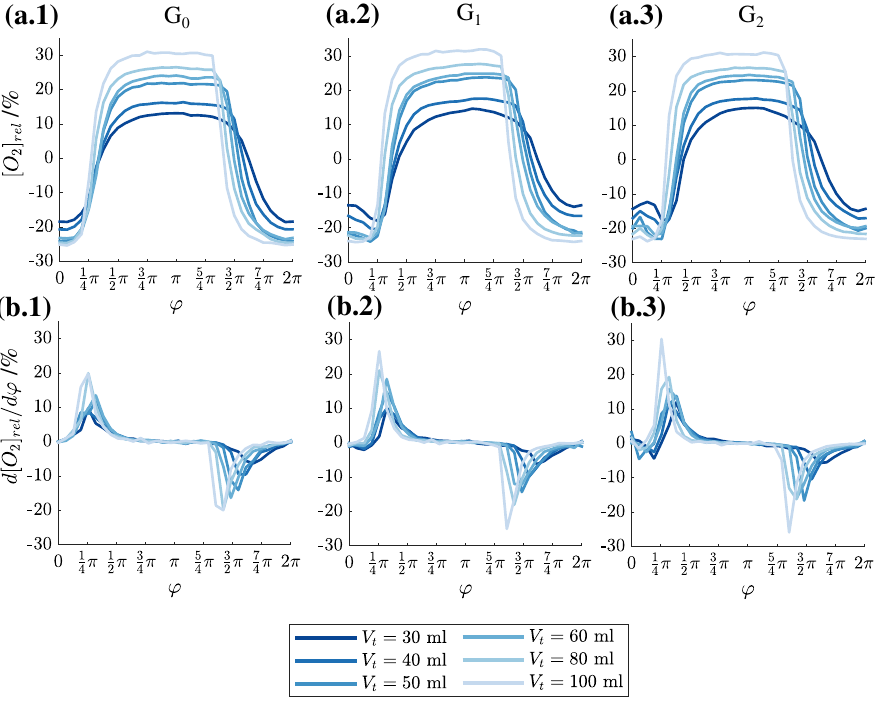
Figure 4. Cross sectional averaged oxygen concentration ( a.1 )–( a.3 ) during a whole breathing cycle and oxygen concentration gradient ( b.1 )–( b.3 ) at f = 0.05 Hz and different tidal volumes in different cross section: (1) G 0 , (2) G 1 , (3) G 2